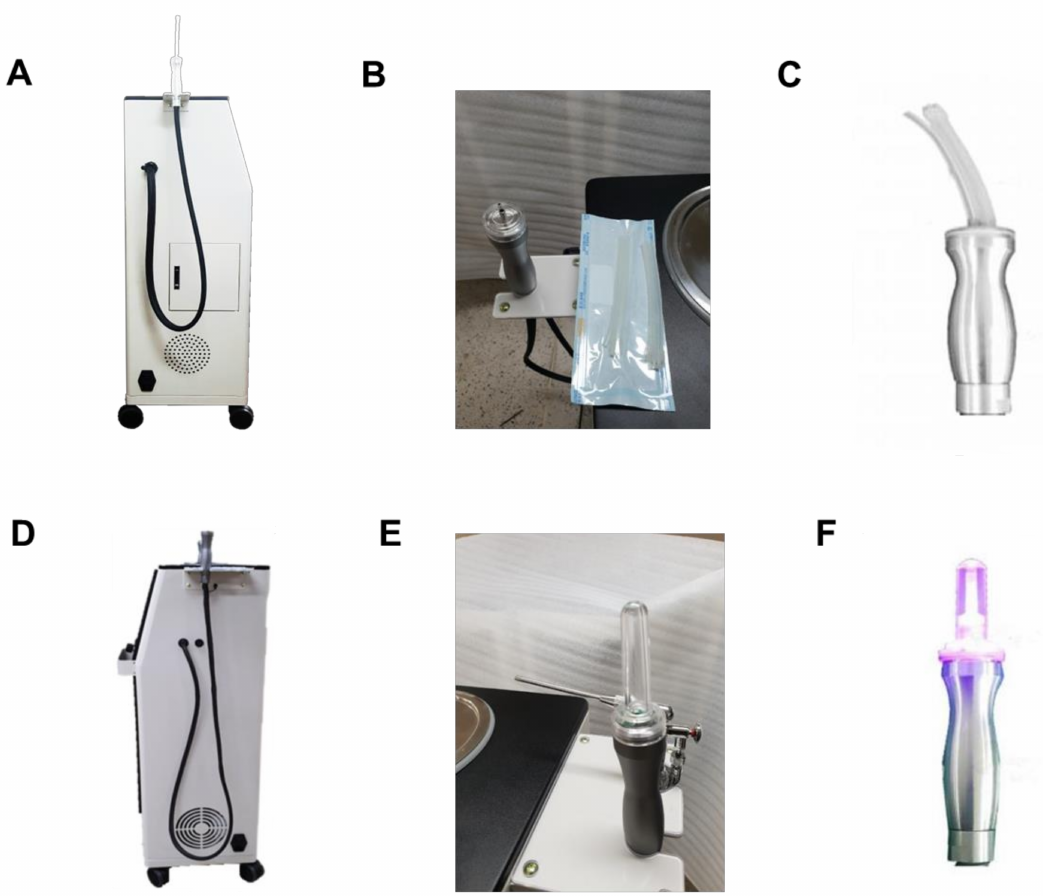
Figure 2. ( A ) A spraying nozzle with cleaning and suction functions, ( B ) the top view of the spraying nozzle and the disposable silicone tube, and ( C ) an image of the silicon tube-connected spraying nozzle. ( D ) The light-generating nozzle with an air pump, ( E ) the top view of the light-generating nozzle and disposable silicone cap, and ( F ) an image of the light-generating nozzle with a silicon